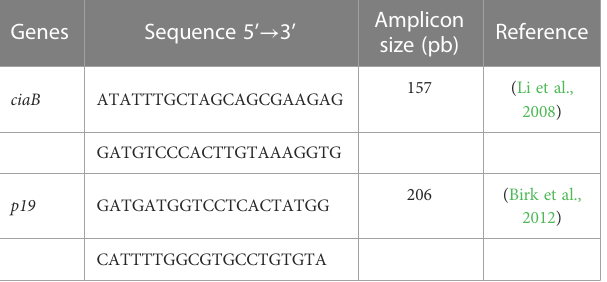
Genes Sequence 5 ’ → 3